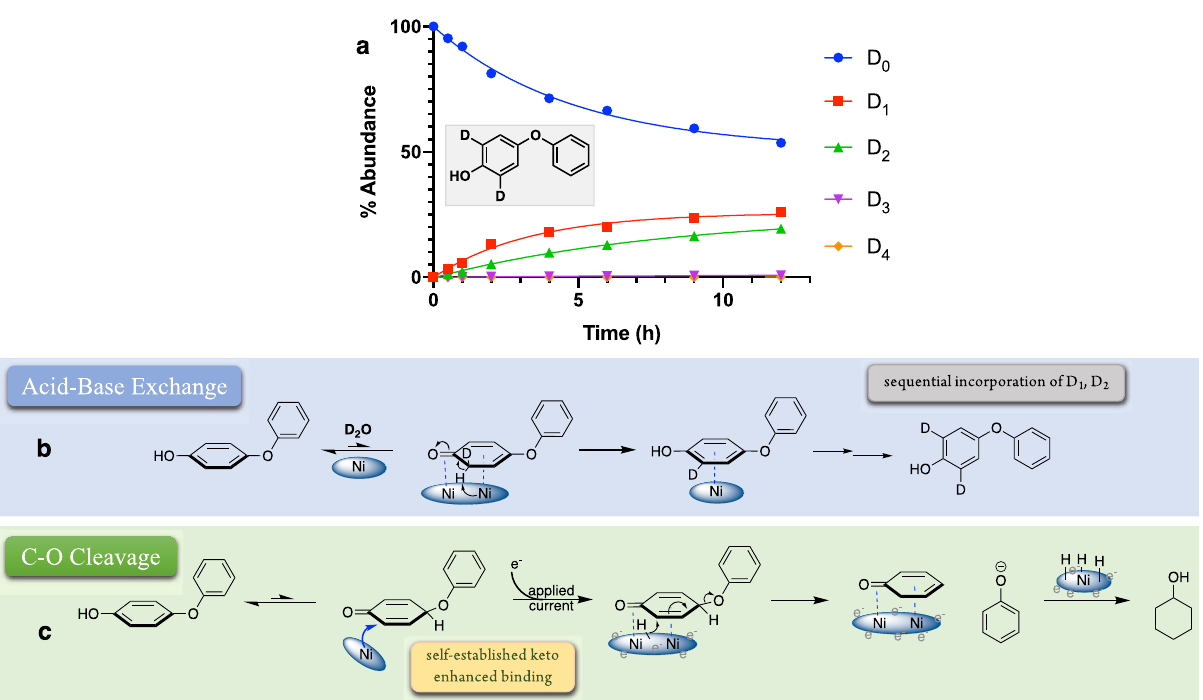
Fig. 6 Effects of hydroxyl substituent on diaryl ether cleavage mechanism. a H/D exchange time courses and exchange locations for hydroxylated diphenyl ether (analysis included a H 2 O wash to eliminate the rapidly exchangeable hydroxyl H). D n ( n = 0 − 4) represent numbers of deuterium atoms incorporated. For additional analyses (NMR and MS Spectra) see supplementary Figs. 21 – 24. b Proposed exchange mechanism for hydroxylated diphenyl ether. c Proposed cleavage mechanisms for hydroxylated diphenyl